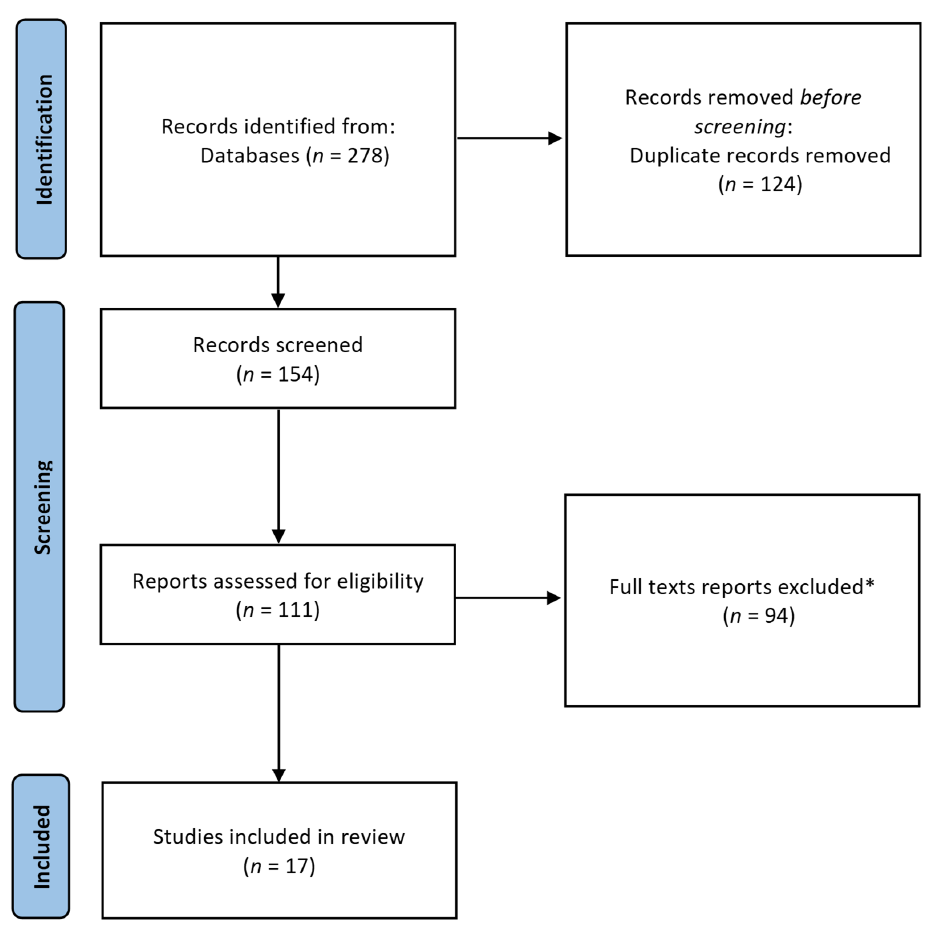
Analyses (PRISMA) [23], used in this study. * Exclusion criteria are reflected in the ‘review method’